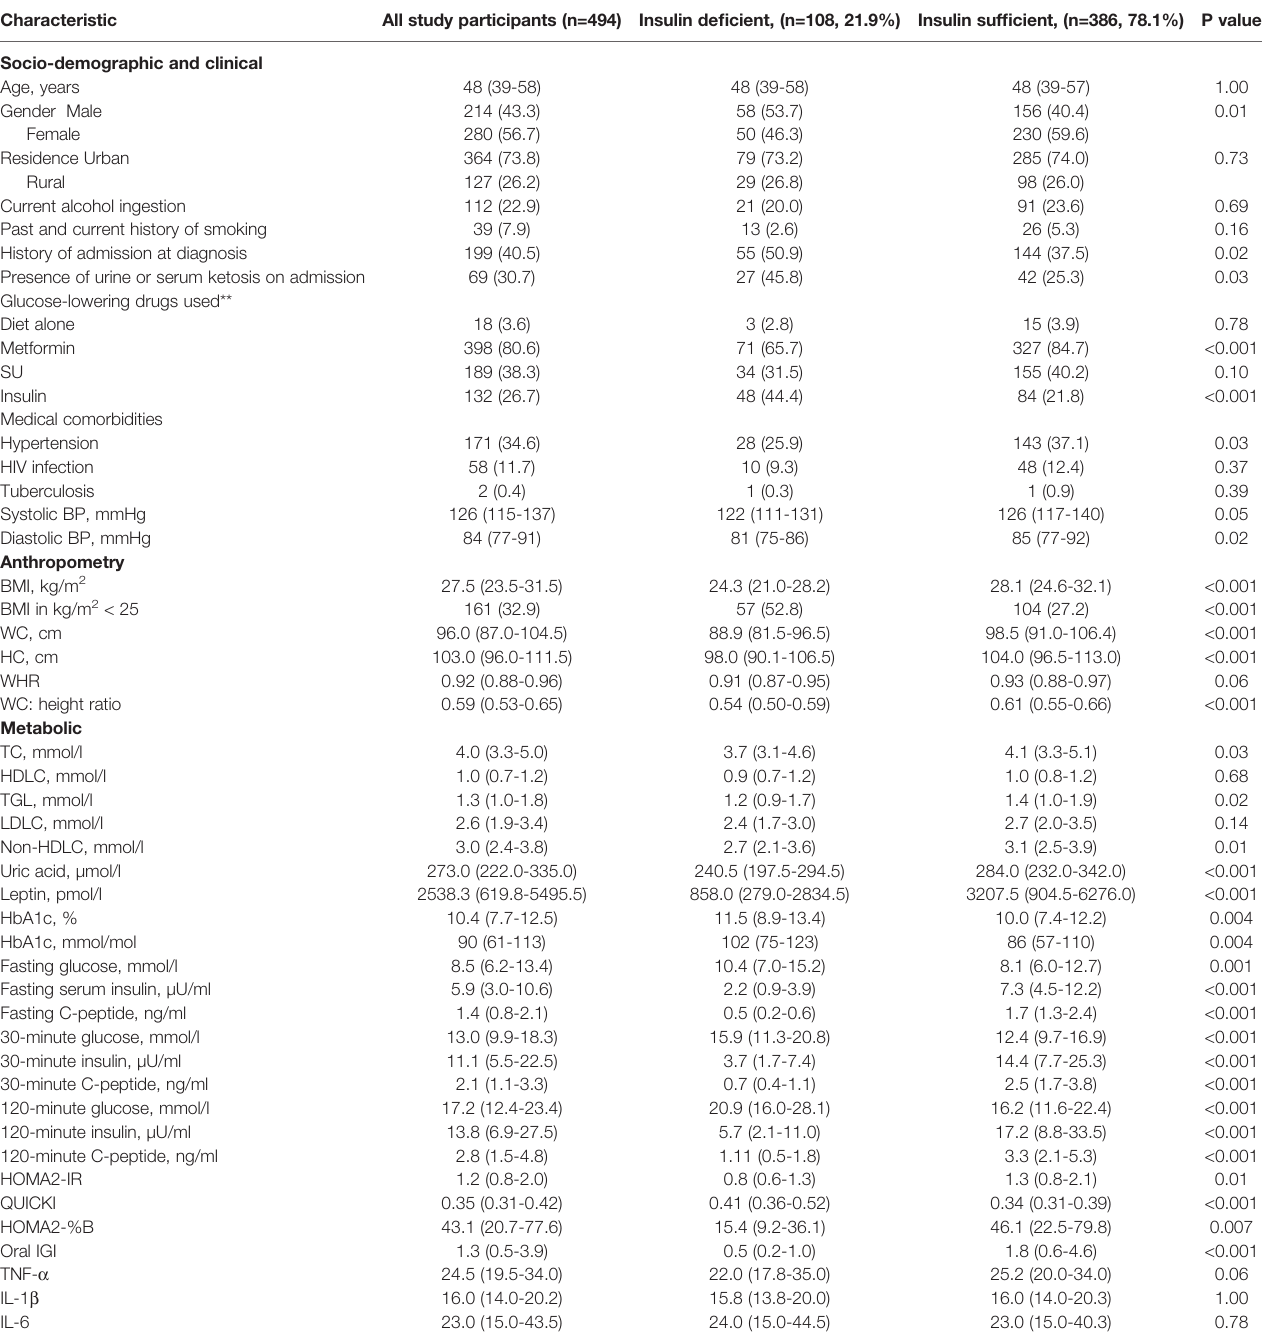
TABLE 1 | Socio-demographic, clinical, anthropometric, and metabolic characteristics of the study participants with and without insulin de fi ciency.